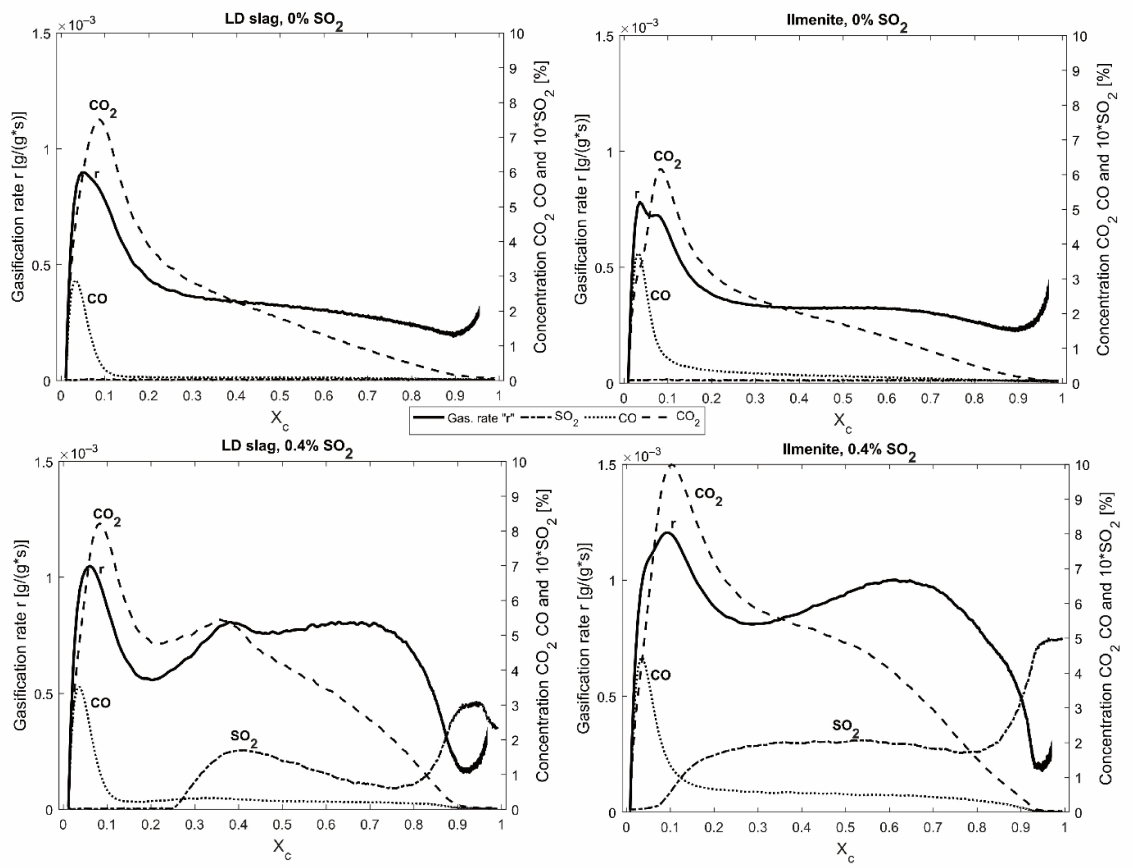
Figure 13. Gasification rate ”r” and concentration of outgoing gases and SO 2 in relation to char conversion X c for LD slag and ilmenite. The two upper figures are without the presence of SO 2 , and the two lower figures are in the presence of 0.4% SO 2 . Note that these experiments are performed with another wood char, German wood char, instead of devolatilized wood pellets, with more volatiles compared to the experiments evaluated in Section